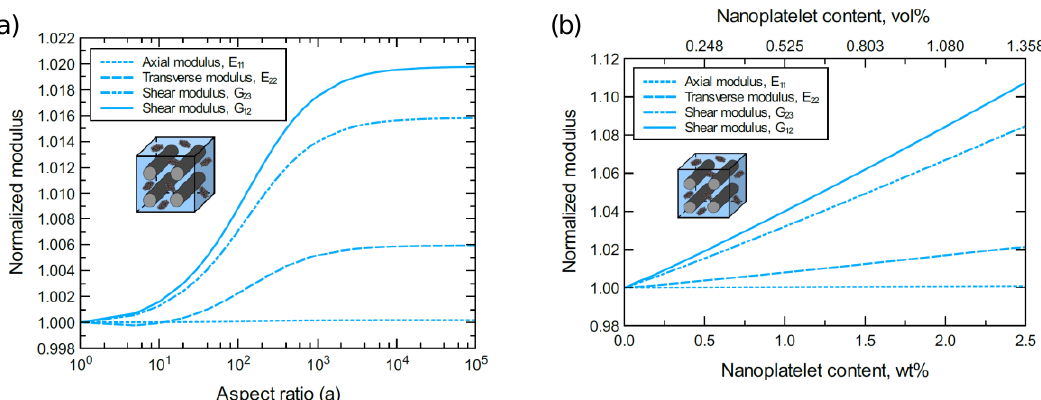
Figure 9. Predicted elastic and shear moduli for unidirectional CF/FGO/epoxy for various nanoplatelet content and aspect ratio values; ( a ) axial elastic modulus 𝐸 11 , ( b ) transverse elastic modulus 𝐸 22 , ( c ) shear modulus 𝐺 12 , ( d ) shear modulus 𝐺 23 . The volume fraction of CF is 56%.